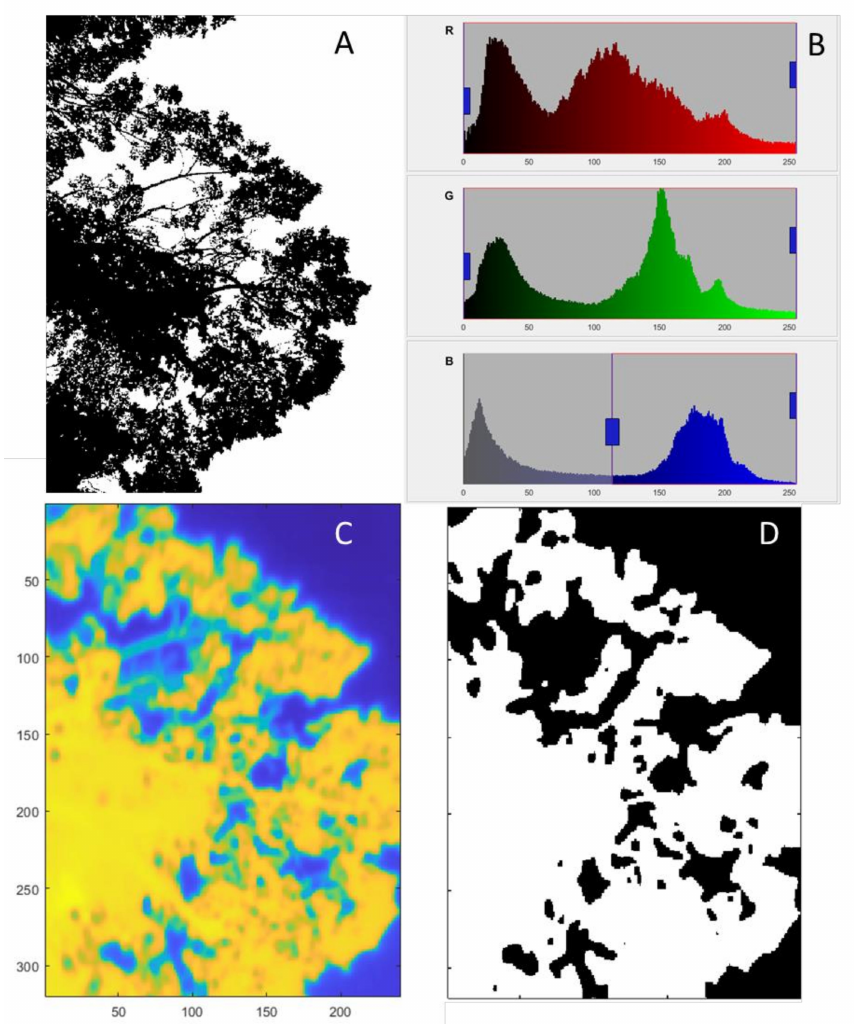
Figure 4. Example of the automated pre-processing of visible (RGB) images transformed to binary images ( A ) using the blue channel as filter ( B ) and the corresponding infrared thermal image ( C ) filtered to create a mask ( D ) to account for leaf